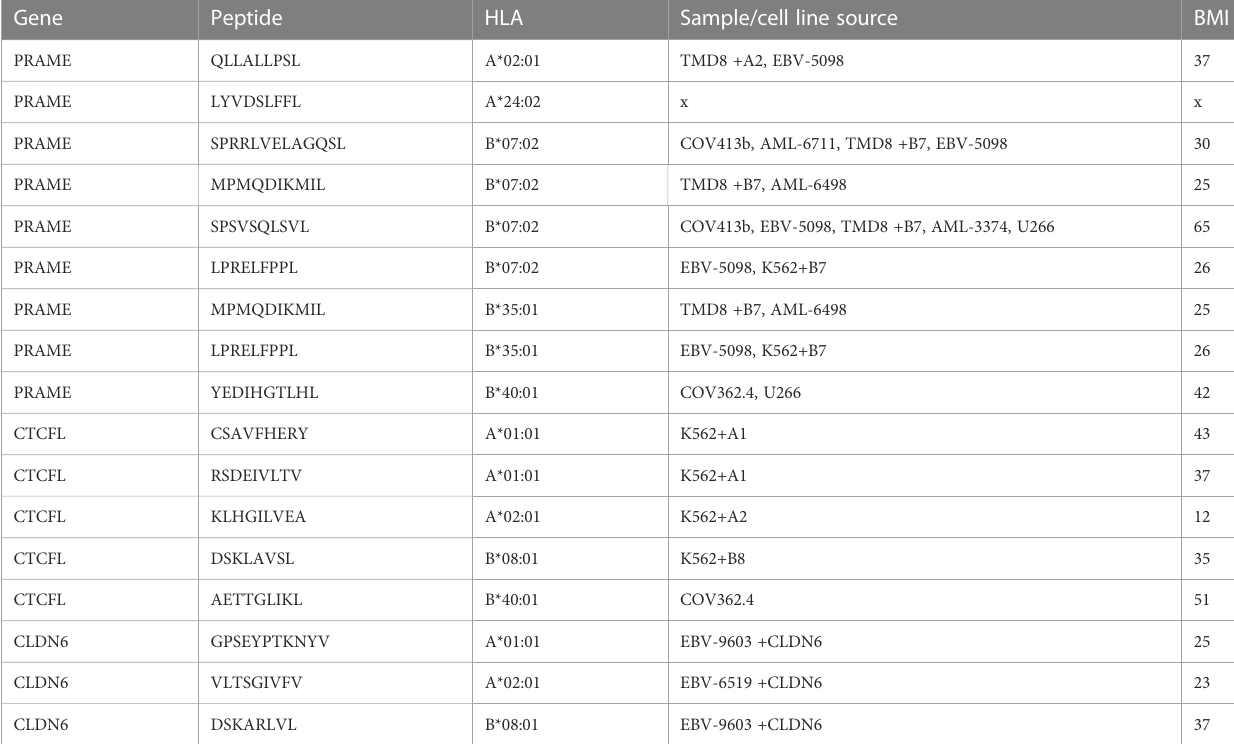
Overview of the 17 OVCA gene-derived peptides included in our T-cell search. For each peptide identi fi ed in our HLA ligandome analyses, the gene, HLA binding restriction, sample/cell line source,andBMIare listed.DetailsofthesamplesandcelllinesarelistedinSupplementaryTable1.TheLYVDSLFFLpeptidebindinginA*24:02wasincludedbasedonliterature(38).BMI,best Mascot ion